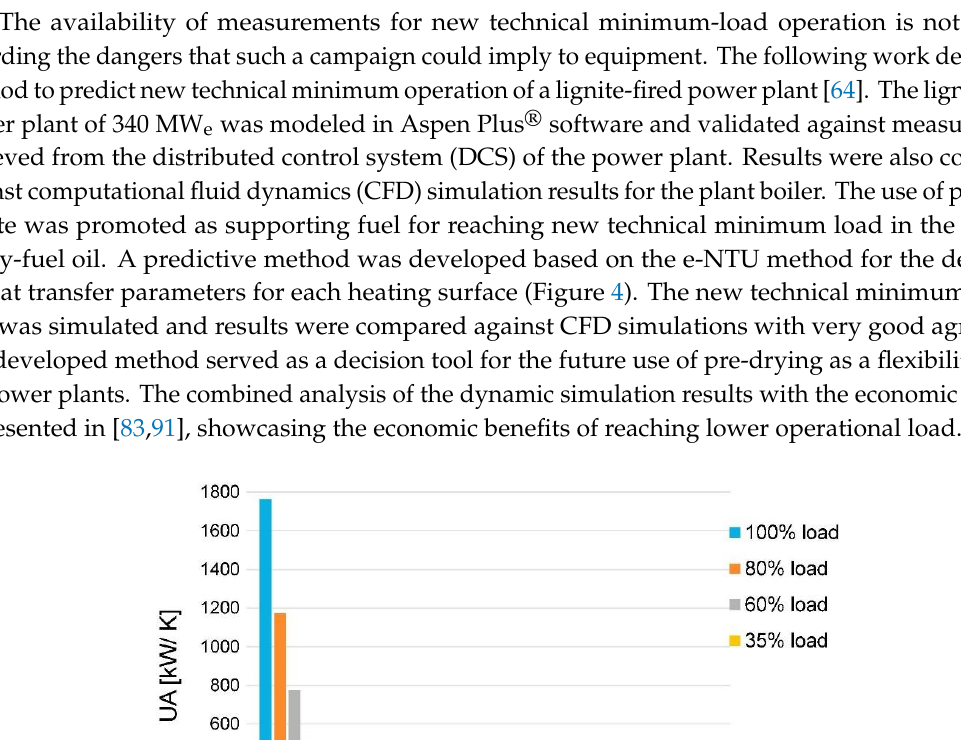
Figure 3. Comparison of heat exchangers for different load levels (100% blue, 60% red, 40% green) for: ( a ) power Q; ( b ) steam temperature difference ∆T at the inlet and outlet for each heat exchanger; Reprint with permission [63]; 2017, IOP Publishing Ltd.